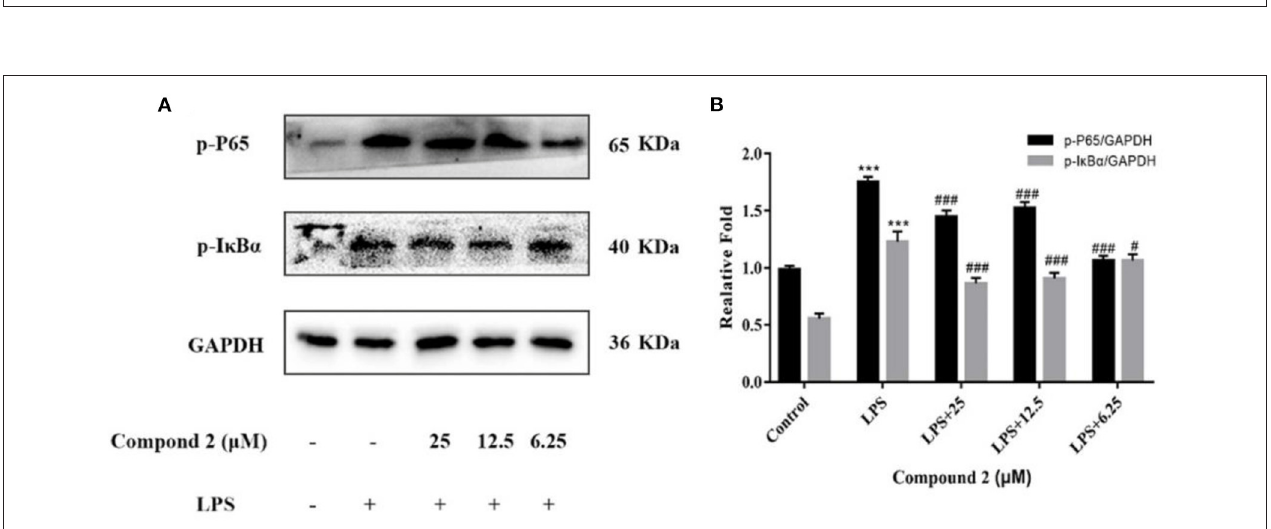
FIGURE 8 | Influences of compound 2 on p-P65, p-I κ B α and GAPDH protein expression detected by the western blotting (A) . The proportion of p-P65 to GAPDH content and p-I κ B α to GAPDH content (B) . Data rendered are the mean ± SD, n = 3. In comparison to the control, *** P < 0.001. In comparison to the LPS, # P < 0.05, ### p <